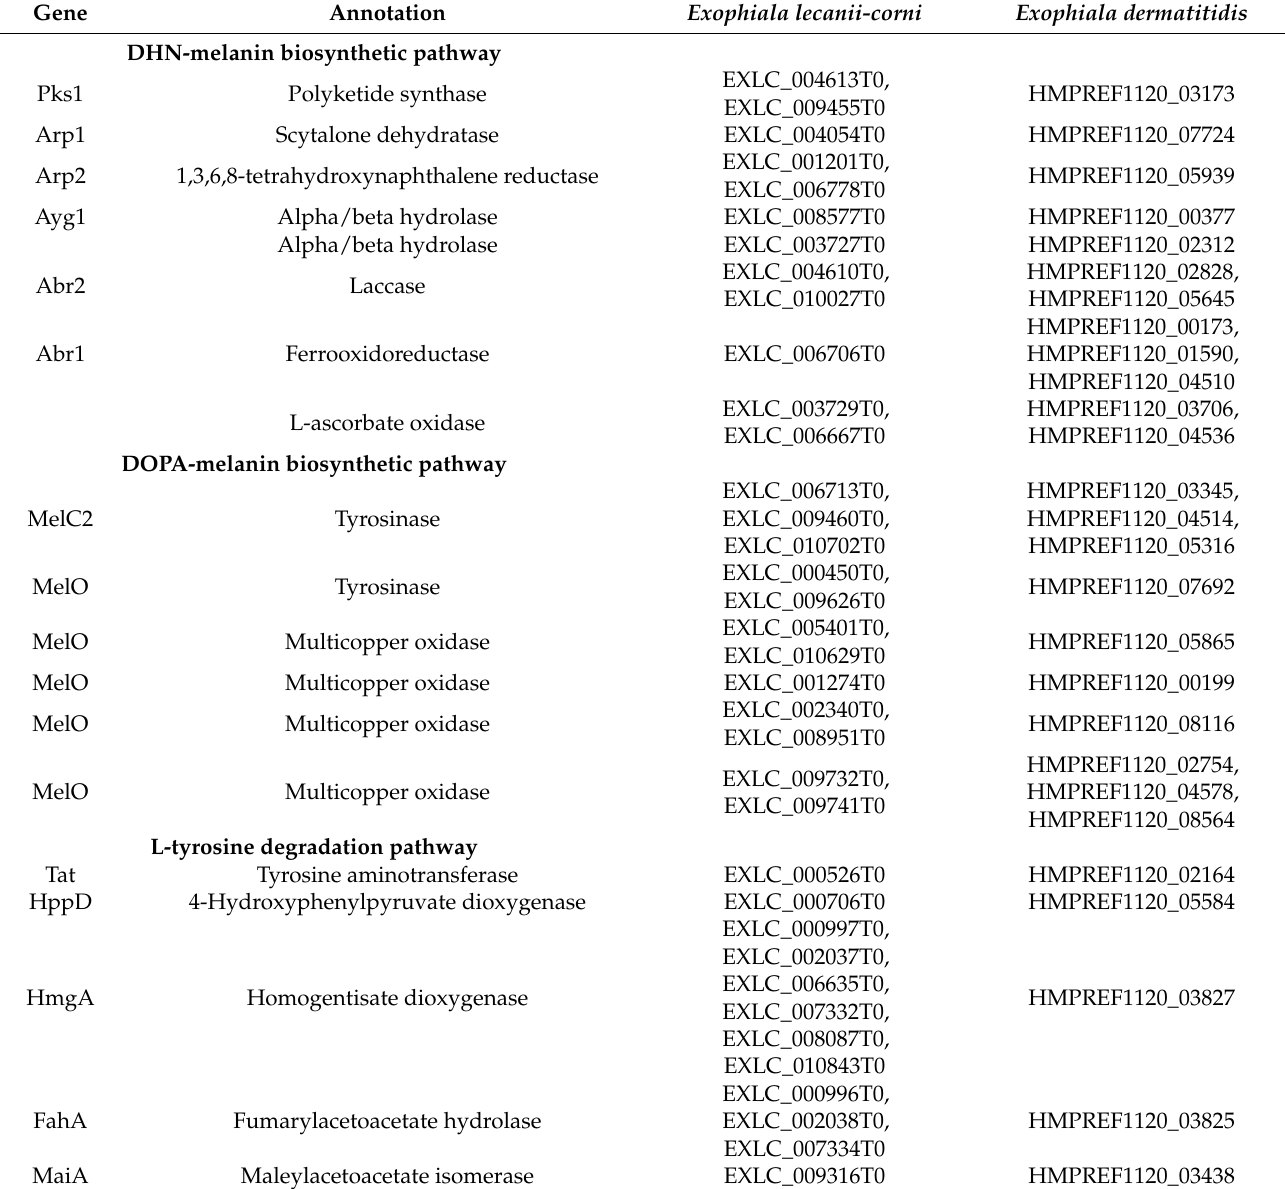
Table 4. Melanin biosynthesis pathway genes present in the genome of E. lecanii-corni compared to E. dermatitidis . Gene Annotation Exophiala lecanii-corni Exophiala